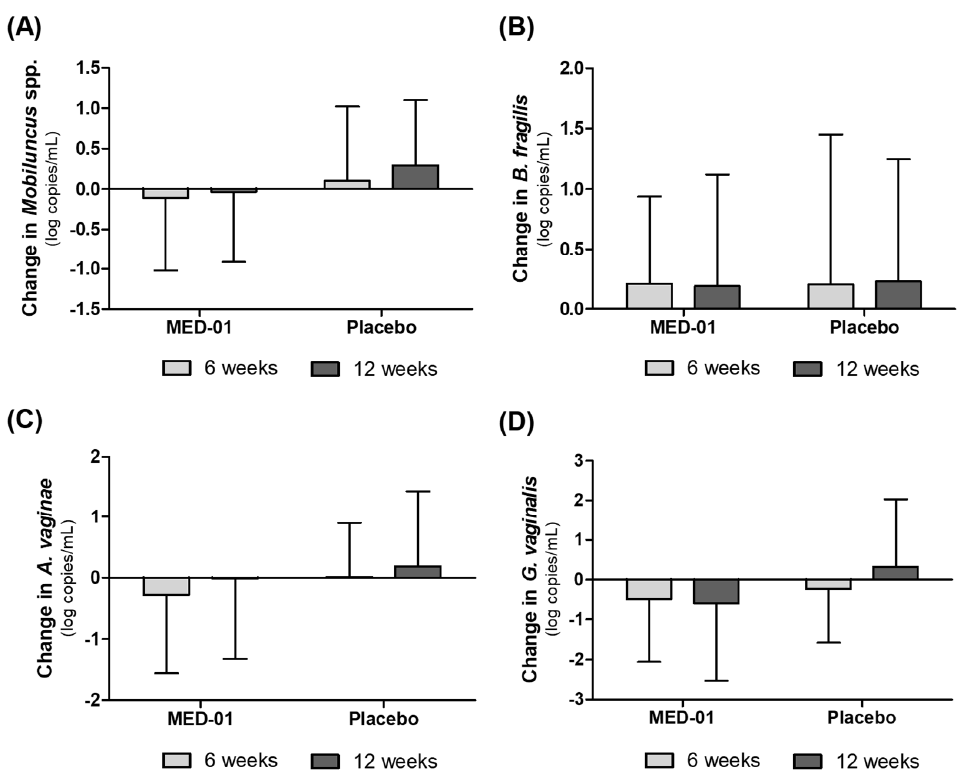
Figure 5. Effect of MED-01 on vaginal BV-inducing bacteria, as determined by quantitative PCR from baseline to 12 weeks after randomization of subjects. ( A ) Mobiluncus spp., ( B ) Bacteroides fragilis, ( C ) Atopobium vaginae, and ( D ) Gardnerella vaginalis . Values are presented as the mean of change in log copies/mL ± SD.